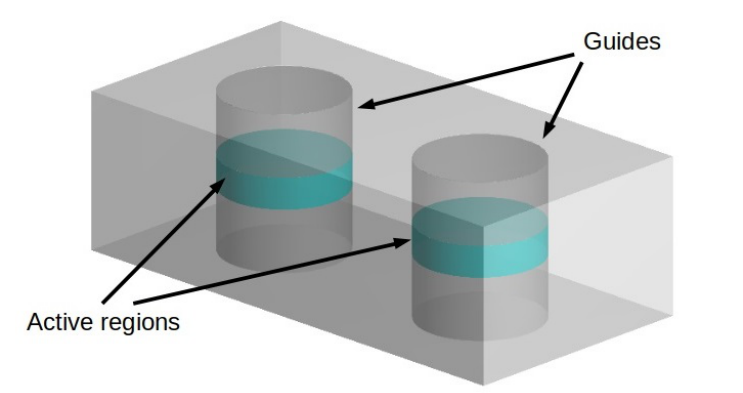
Figure 2. A three-dimensional (3D) schematic of two coupled circular waveguides encapsulating the essence of the application to a pair of vertical cavity surface emitting laser (VCSEL) cavities. Shown are the cylindrical waveguide regions incorporating the active areas. Pumping is assumed to be confined to these regions. Note that we have omitted the Bragg stack mirrors and substrate from this